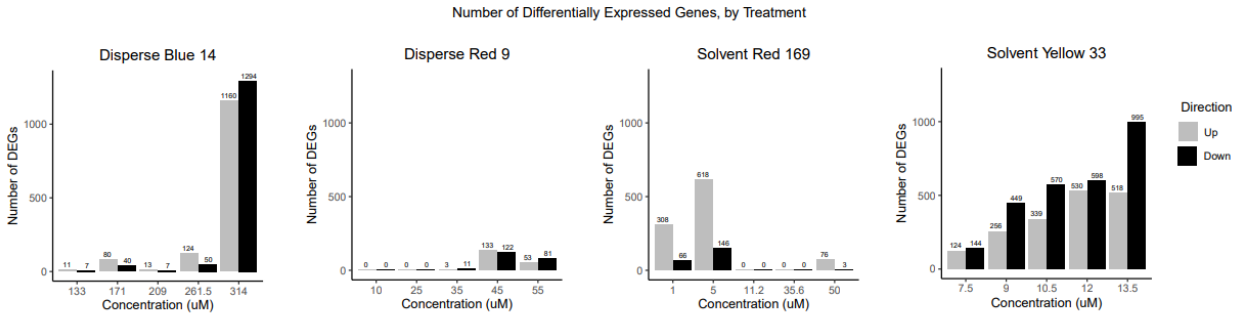
Figure 4. Number of up- and downregulated differentially expressed genes for the Disperse Blue 14, Disperse Red 9, Solvent Red 169 and Solvent Yellow 33 treatment groups.